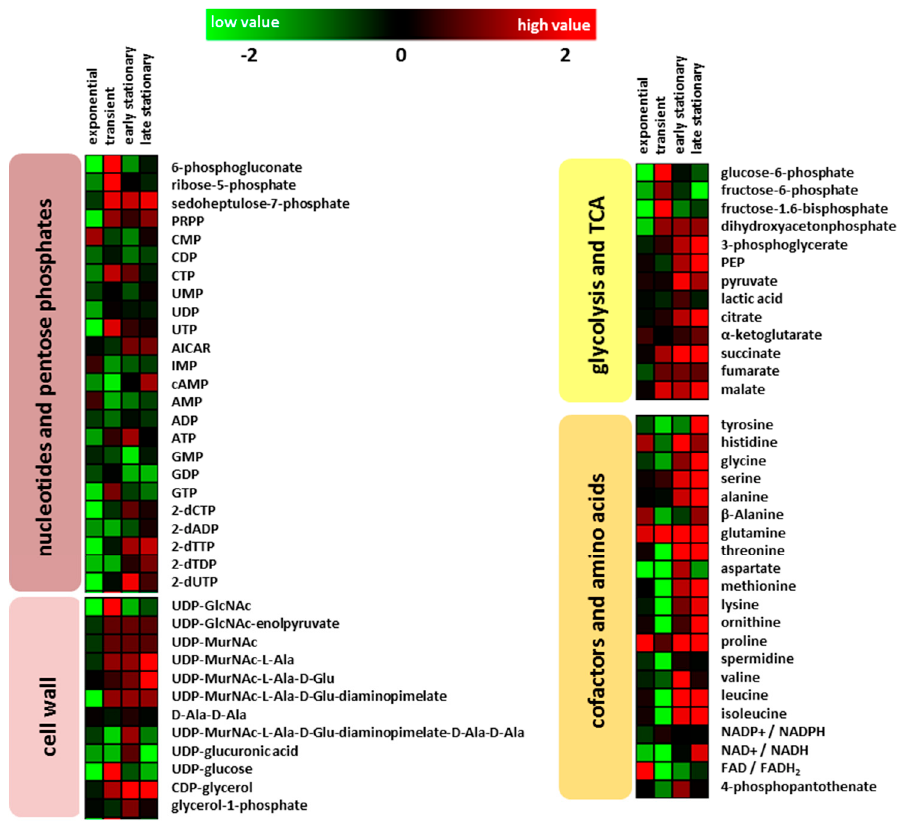
Figure 2. Color-coded heatmaps displaying fold change log 2 ( clpP mutant/wild type) of intracellular metabolite amounts for the different growth phases (exponential: for wild type after 90 min and mutant after 150 min; transient: for wild type after 180 min and mutant after 210 min; early stationary: for both after 300 min and late stationary growth phase: for both after 600 min) of four biological replicates.